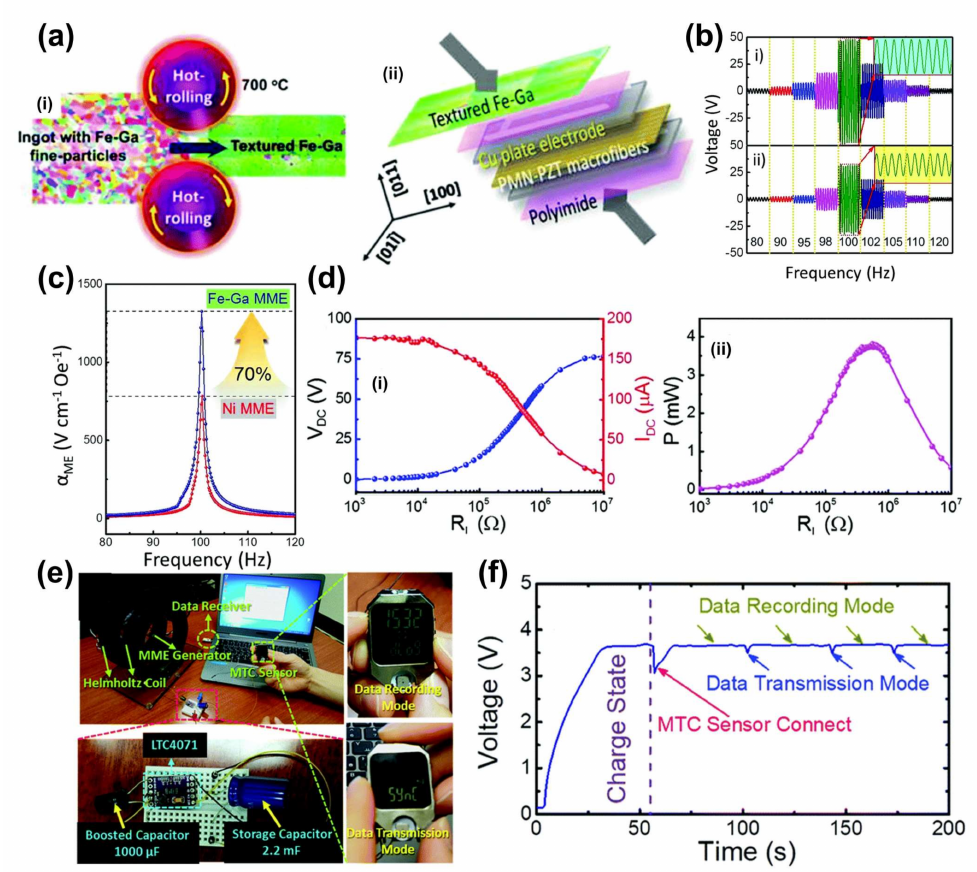
Figure 6. ( a ) ( i ) Schematic diagram of synthesis process of textured Fe − Ga. ( a ) ( ii ) fabrication steps for the ME composite. ( b ) Generated voltage signals from MME generators embedded with textured Fe − Ga ( i ) and Ni ( ii ) layers measured at different frequencies ( c ) ME voltage coefficient ( α ME ) as a function of HAC driving frequency. ( d ) Rectified DC voltage/current signals ( i ) and DC output power ( ii ) of Fe − Ga MME generator under 700 µ T at 60 Hz. ( e ) Energy harvesting performance of standalone-powered wireless sensor system using MME generator ( f ) Charging and discharging response of storage capacitor. Reproduced with permission